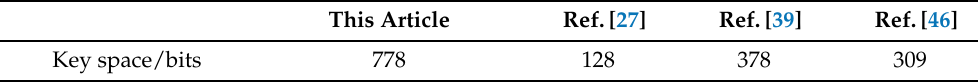
Table 4. Key space size comparison